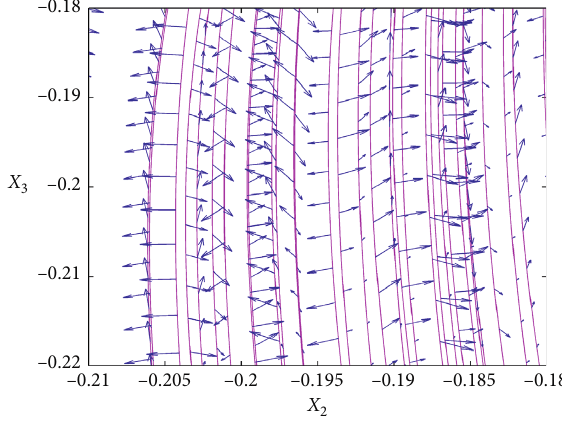
Figure 8: Zoom map of Figure